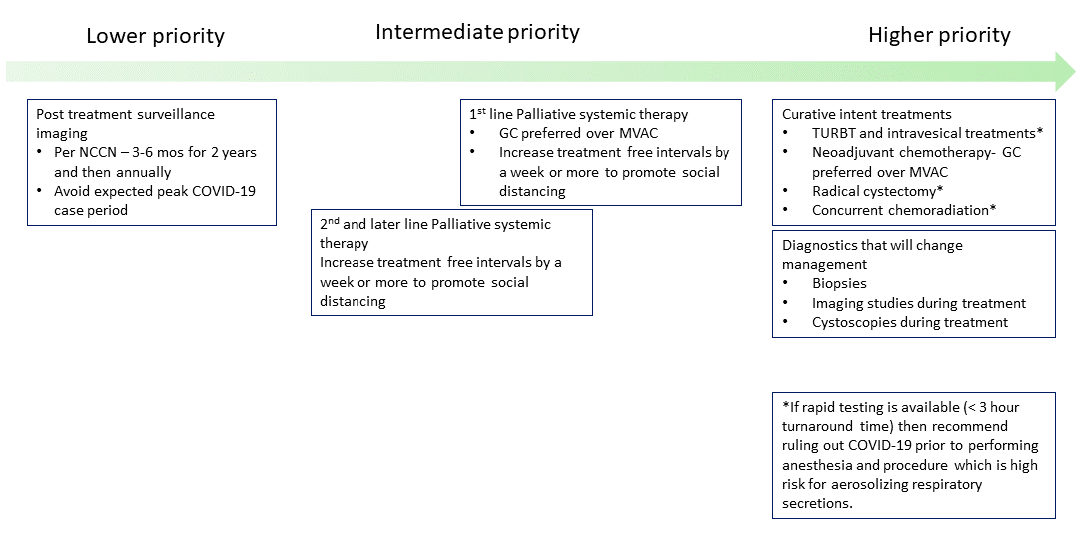
Figure 1. Conceptual framework for prioritizing bladder cancer treatments during the COVID-19